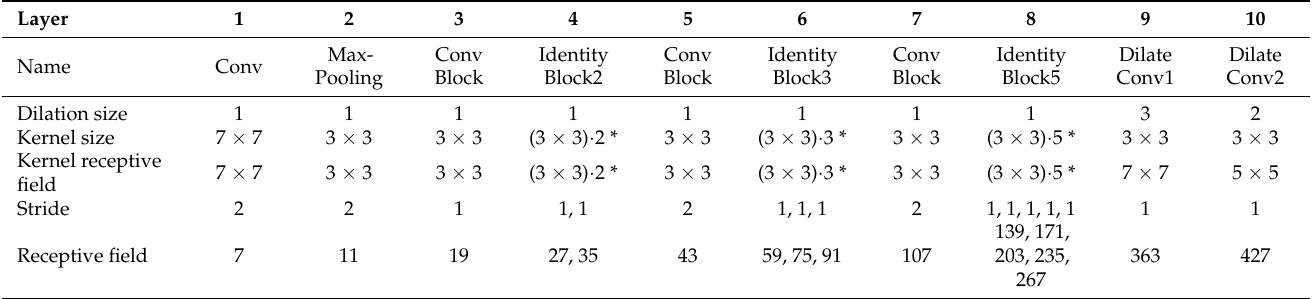
Table 1. Feature extraction network for each layer receptive field size.